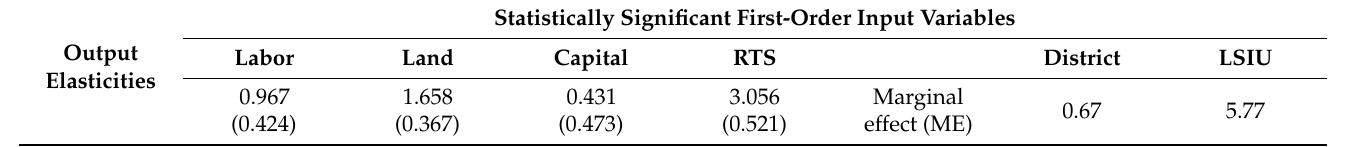
Table 4. Output elasticities of inputs at the sample mean and RTS